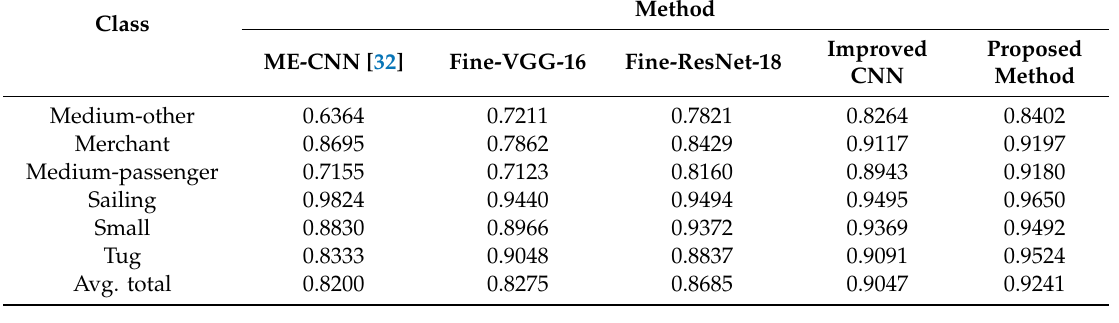
Table 12. F1-score obtained using different CNN methods when applied to the VAIS dataset.